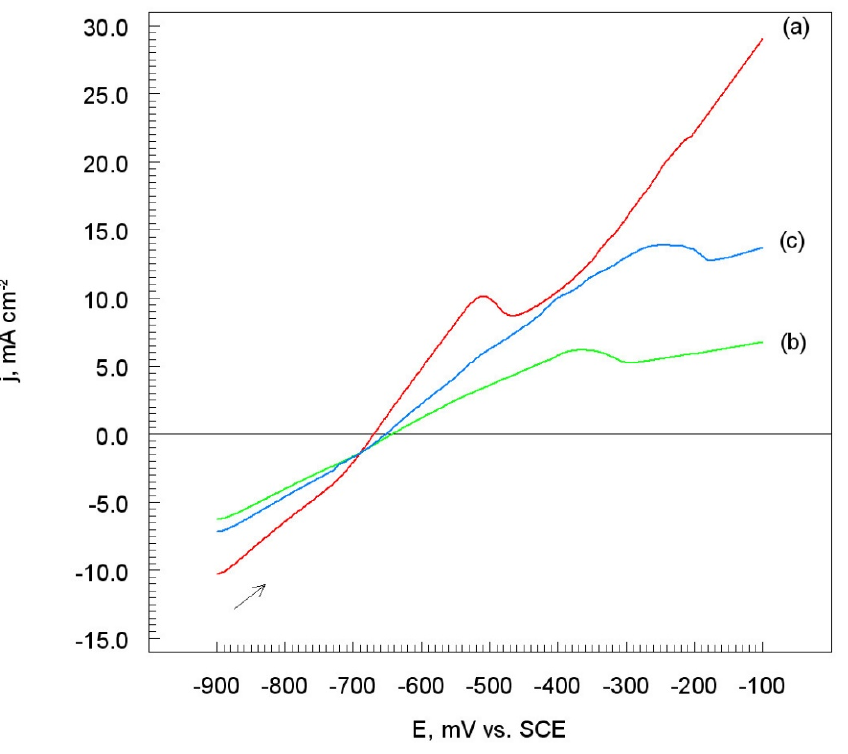
Figure 5. Potentiodynamic polarization curves of titanium coatings onto Al7075 substrate deposited at SoD of: ( a ) 20 mm, ( b ) 70 mm, and ( c ) 100 mm. Solutions contained 1.2 M Cl − , pH 1.5, dE/dt 1 mV s − 1 .